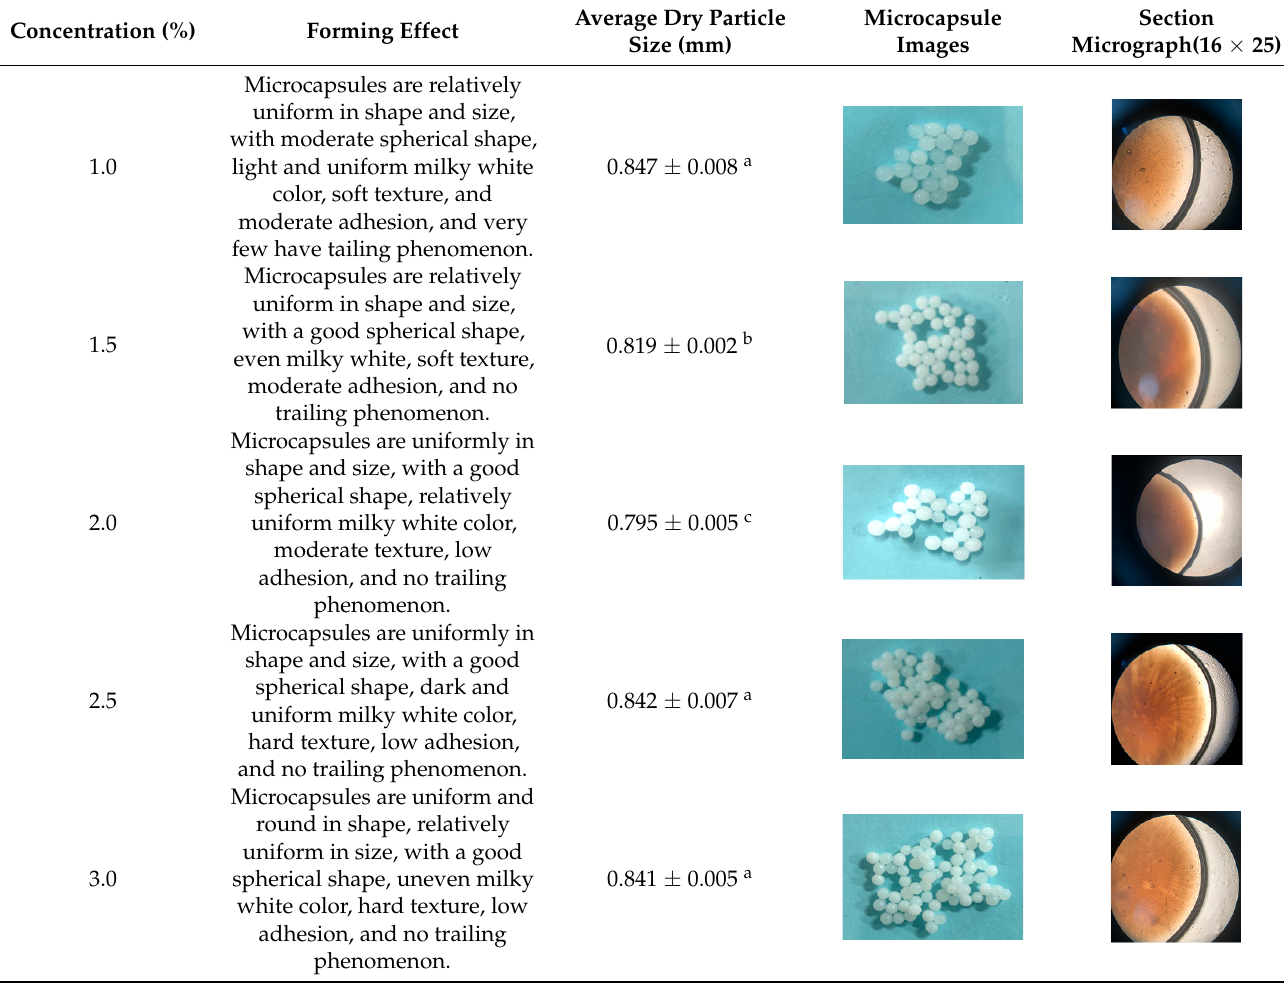
Table 4. Effect of CS concentration on microcapsule formation.